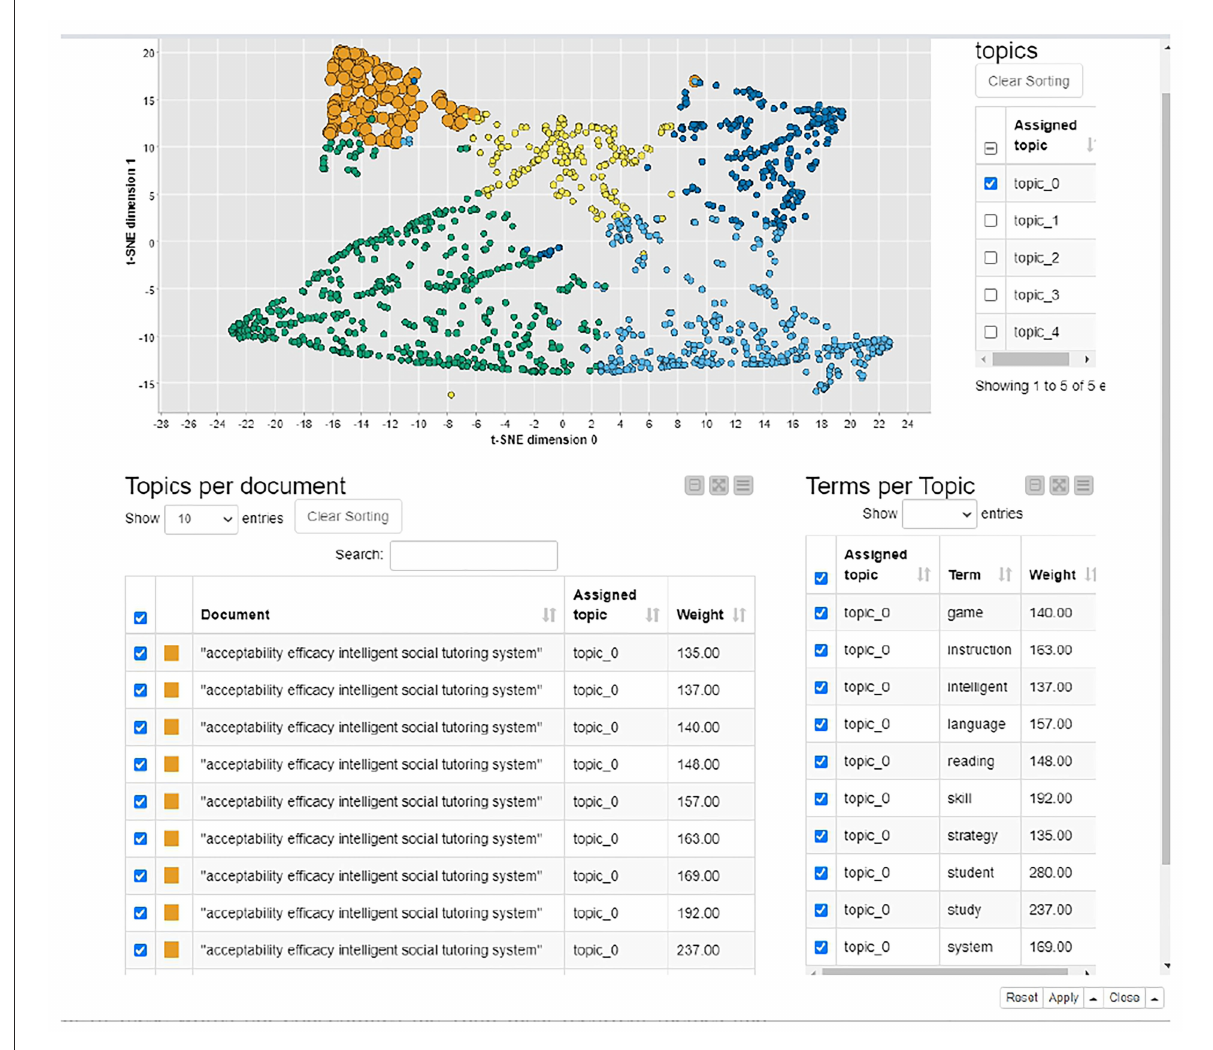
FIGURE8 Inspect topics and terms